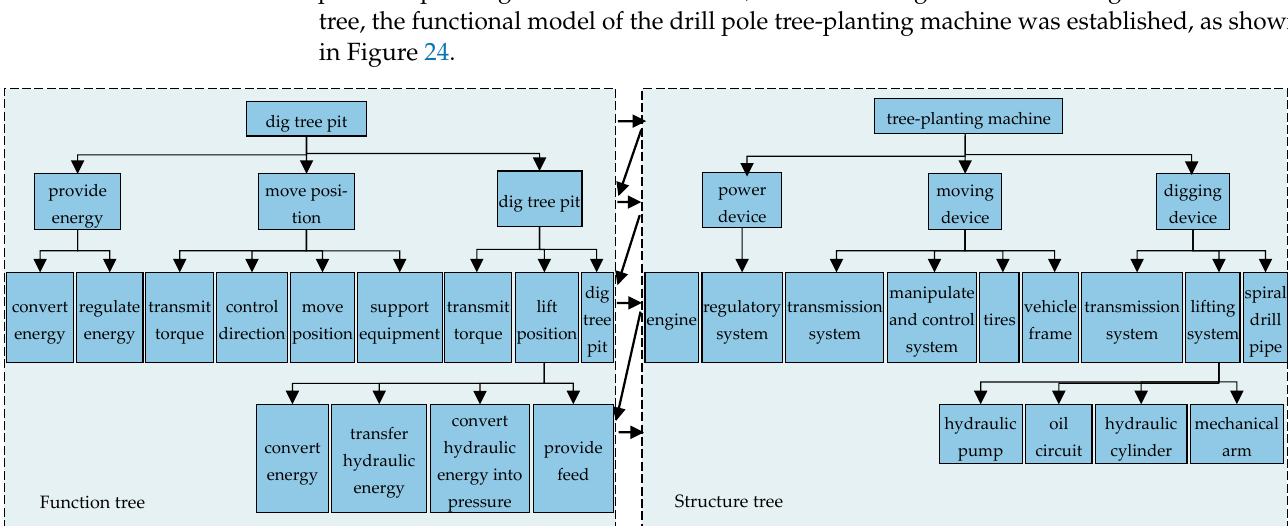
Figure 23. Functional structure of the drill pole tree-planting machine.